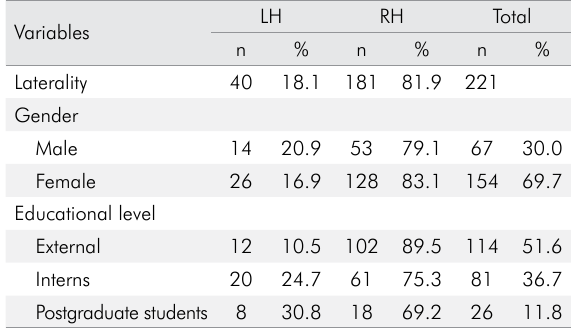
Table 1. Demographic data of study